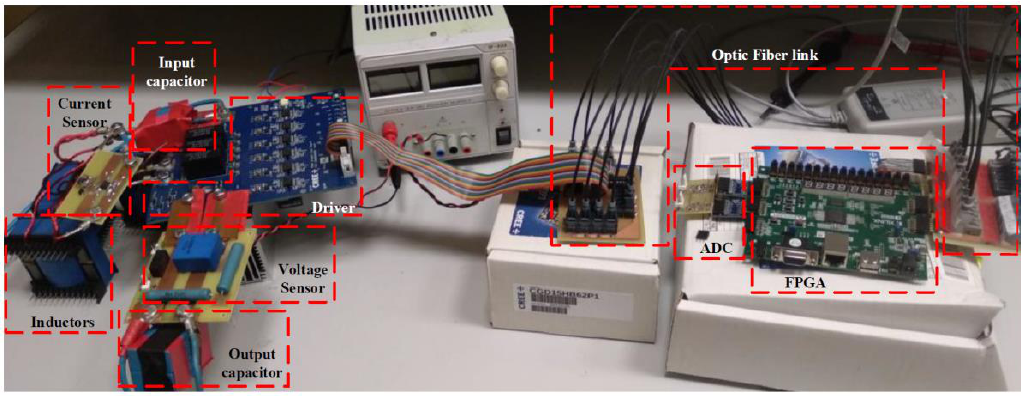
Figure 12. Prototype: power stage, current and voltage sensors on the left part of the image and optic fiber link and control stage on the right part of the picture.